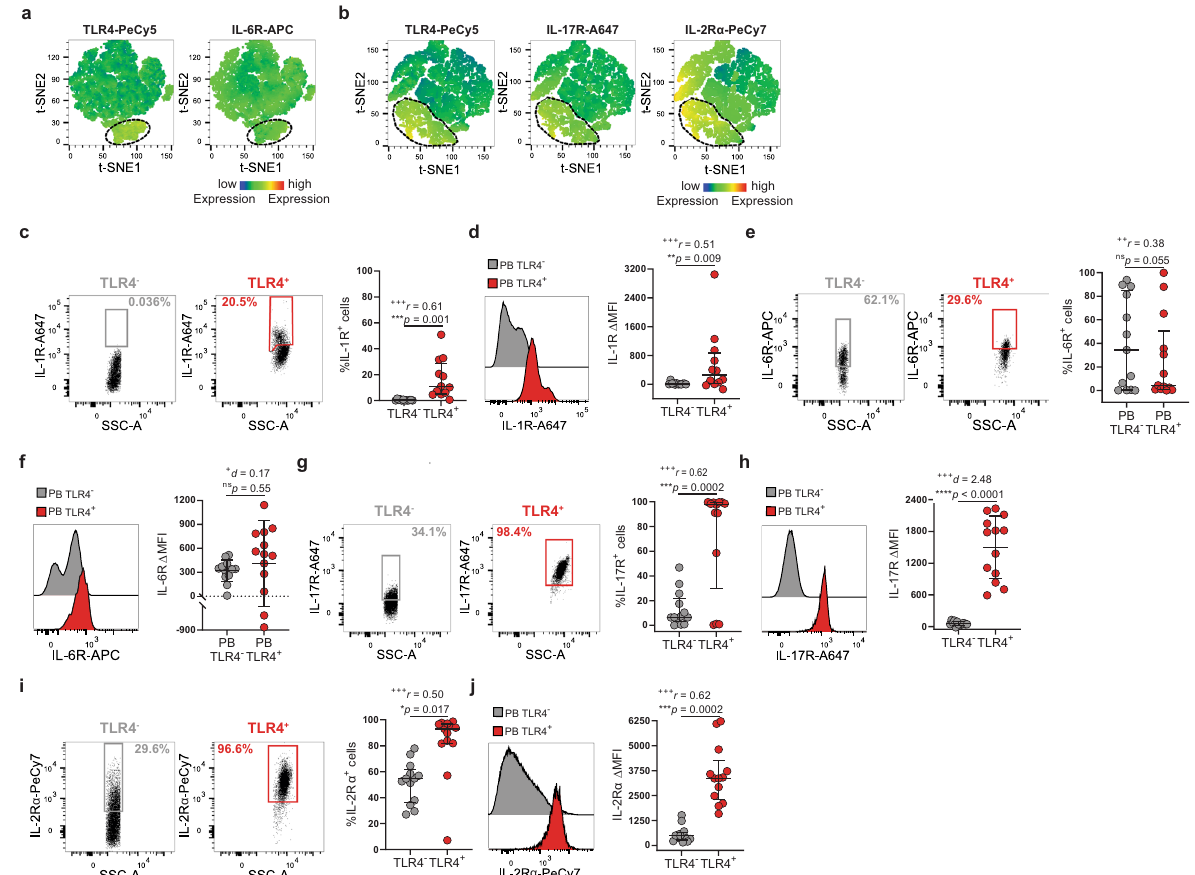
Fig. 8 TLR4 + T cells upregulate receptors for in fl ammatory chemokine cytokines. a , b t-SNE plots of peripheral blood total CD4 + T cells. The color indicates cell expression levels of the labeled marker. a TLR4, IL-6R; TLR4, IL-17R, and IL-2R α . Circle demarks TLR4 + cells ( n = 6 RA patients). c , d Representative plots and cumulative graph ( n = 12 RA patients) of IL-1R c frequency and d Δ MFI in TLR4 + (red) and TLR4 − (gray) T cells. e , f Representative plots and cumulative graph ( n = 13 RA patients) of IL-6R e frequency and f Δ MFI in TLR4 + (red) and TLR4 − (gray) T cells. g , h Representative plots and cumulative graph ( n = 13 RA patients) of IL-17R g frequency and h Δ MFI in TLR4 + (red) and TLR4 − (gray) T cells. i – j Representative plots and cumulative graph ( n = 13 RA patients) of IL-2R α i frequency and j Δ MFI in TLR4 + (red) and TLR4 − (gray) T cells. Δ MFI was calculated to correct for the distinct auto fl uorescence of the TLR4 − and TLR4 + T-cell populations. Δ MFI was calculated by subtracting the fl uorescence intensity minus one (FMO) from median fl uorescence intensity (MFI) for each given marker. Data are presented as mean ± SD, for parametric statistical tests, or median ± IQR, for non-parametric statistical tests. Sample normality distribution was tested by using D ’ Agostino & Pearson normality test.